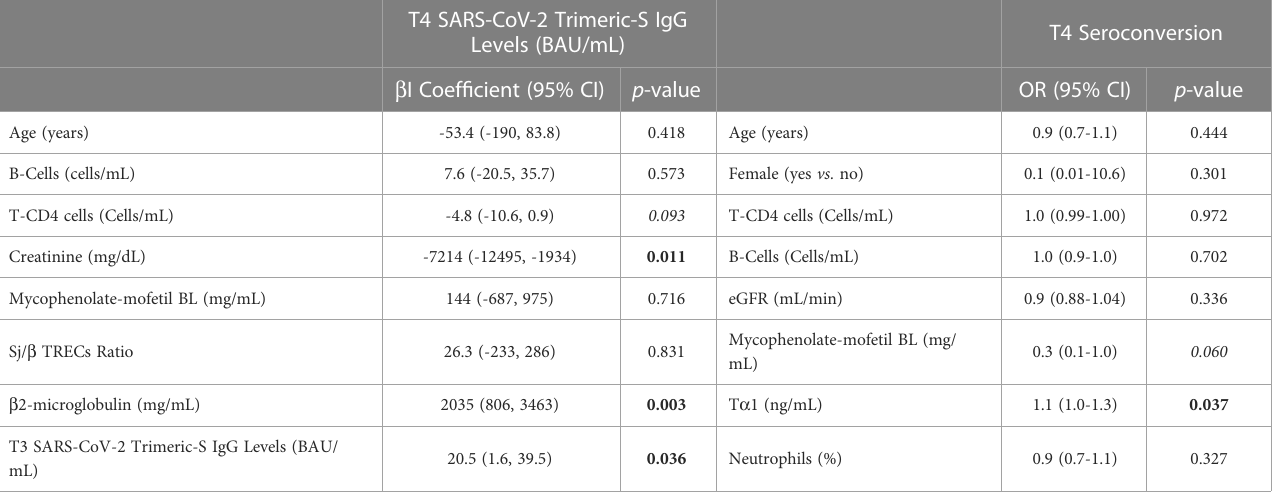
TABLE 3 Multivariable analysis of potential predictive factors (baseline determinations) in seroconversion and magnitude of humoral response to COVID- 19 vaccine in